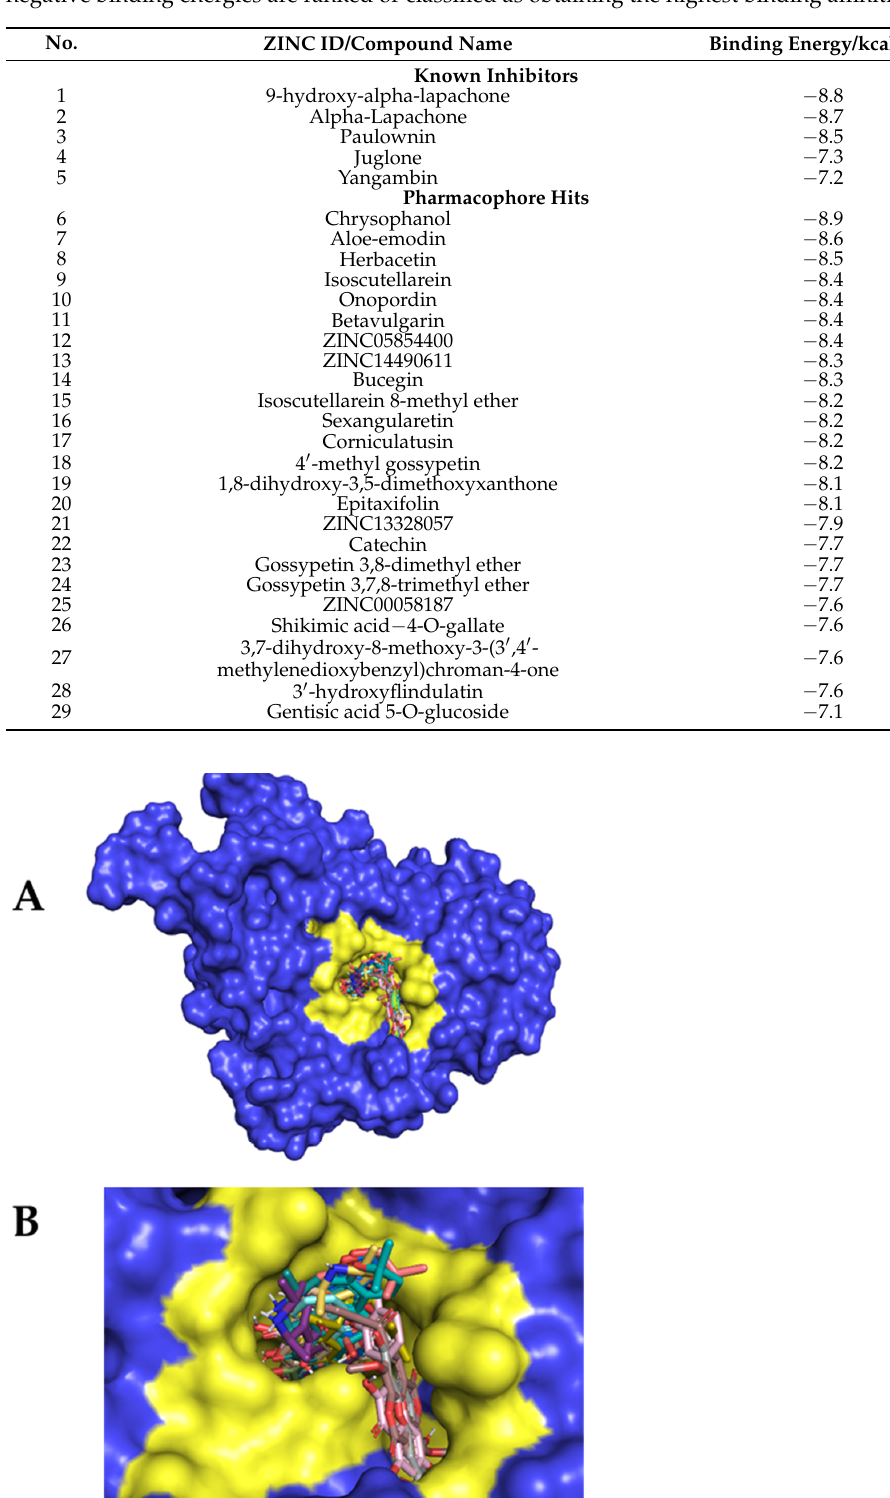
Table 3. Binding energies of top 24 ligands after molecular docking. The ligands with the more negative binding energies are ranked or classified as obtaining the highest binding affinities.